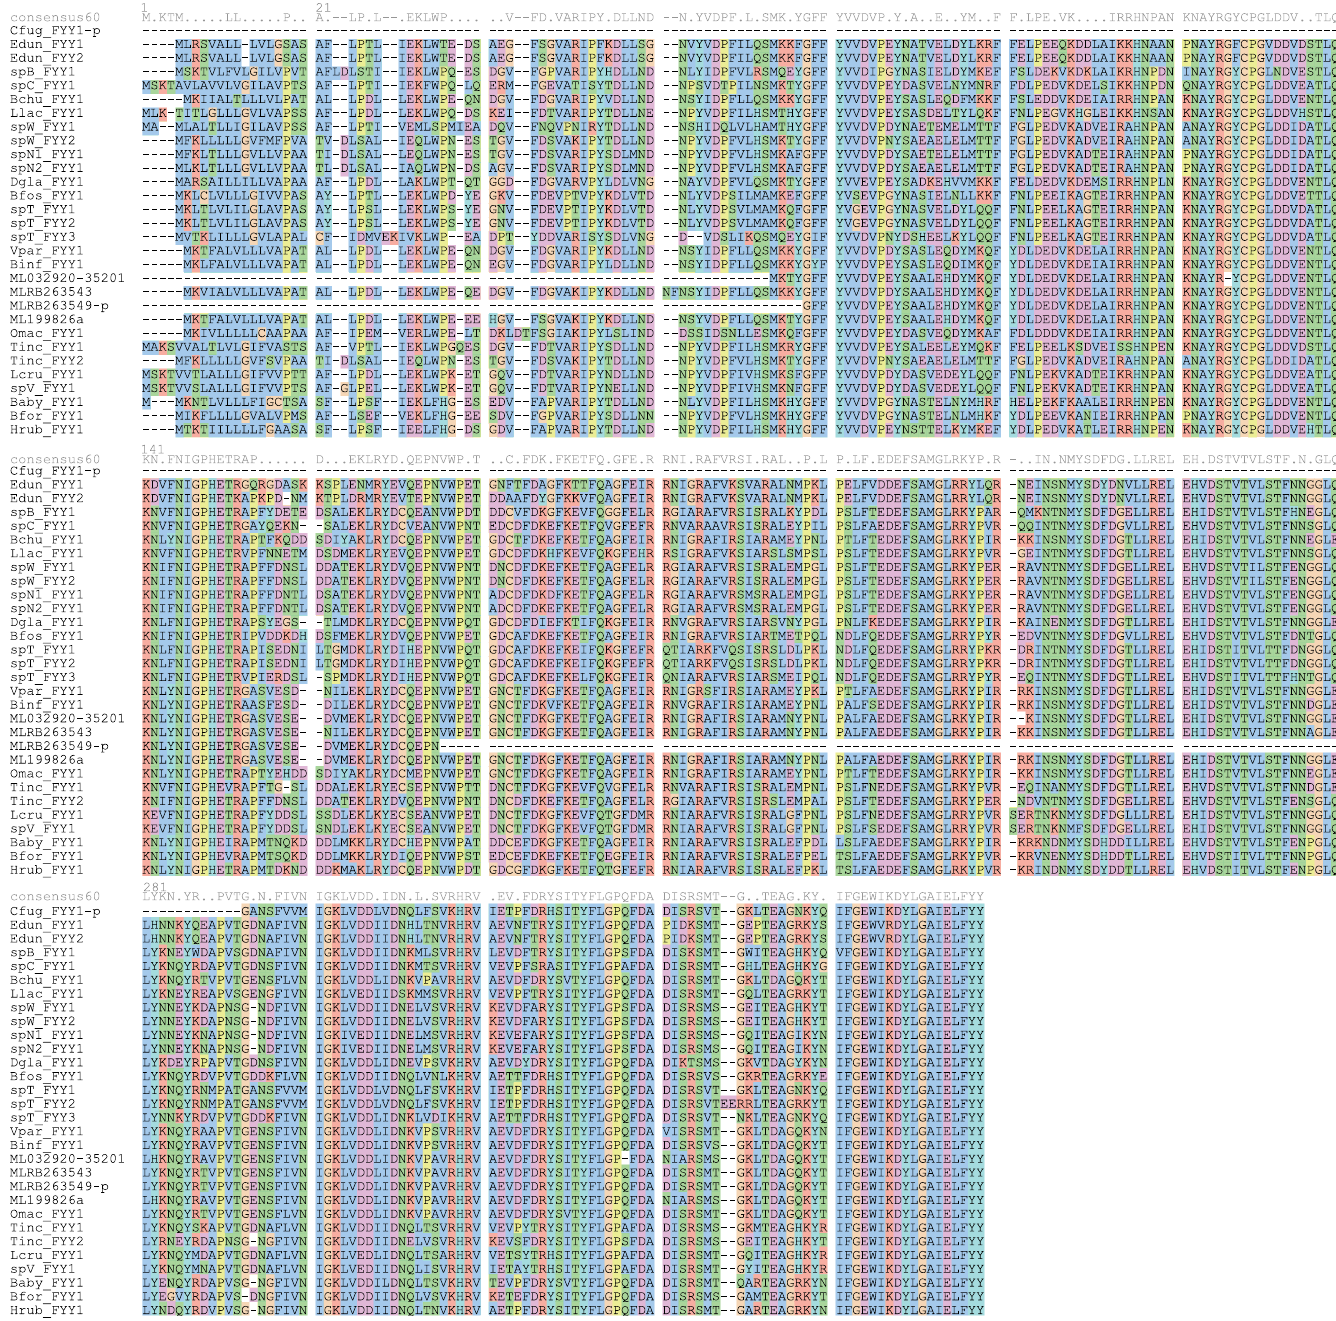
Fig 4. Multiple sequence alignment of all FYY proteins. Alignment of all FYY proteins across ctenophores. Partial sequences were excluded to show the high degree of identity, though they were used for subsequent analysis. The iron-binding residues are indicated by the black box above the consensus line. Species abbreviations are as follows: Bfos, Bathocyroe fosteri ; Bchu, Bathyctena chuni ; Baby, Beroe abyssicola ; Bfor, Beroe forskalii ; Binf, Bolinopsis infundibulum ; Dgla, Dryodora glandiformis ; Edun, Euplokamis dunlapae ; Hrub, Haeckelia rubra ; Llac, Lampea lactea ; Lcru, Lampocteis cruentiventer ; ML, Mnemiopsis leidyi ; Omac, Ocyropsis maculata ; Tinc, Thalassocalyce inconstans ; spB, Undescribed ctenophore B ; spC, Undescribed ctenophore C ; spN1, Undescribed ctenophore N1 ; spN2, Undescribed ctenophore N2 ; spT, Undescribed ctenophore T ; spV, Undescribed ctenophore V ; Vpar, Velamen parallelum